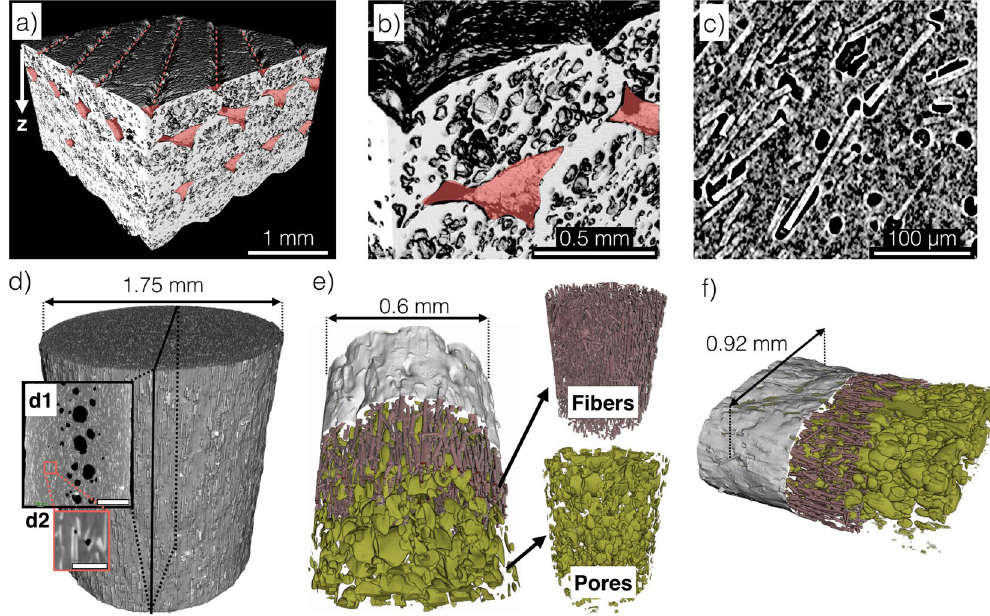
Figure 2. X-ray computed tomography images of ( a ) infill = 100% composite showing inter-bead porosity as red shaded areas, ( b ) beads with inter- and inner-bead porosity, ( c ) carbon fibers and pores at the fiber ends and around fibers, ( d ) as-received filament, ( e ) extruded filament with fiber and pore distribution, and ( f ) extruded filament that was deposited on the hot bed. ABS is shown in shades of gray in ( a ) to ( f ). Black represents pores in ( c ) and ( d ). Dark green represents pores and dark red represents carbon fibers in ( e ) and ( f ). The porosities (vol.%) are ( d ) 5, ( e ) 20, and ( f ) 22. The carbon fiber content (vol.%) are ( d ) 7, ( e ) 6, and ( f ) 10. Scale bars represent 500 μ m for d1 and 100 μ m for d2. Isotropic voxels of linear dimensions are 4.4 μ m for ( a ) and ( b